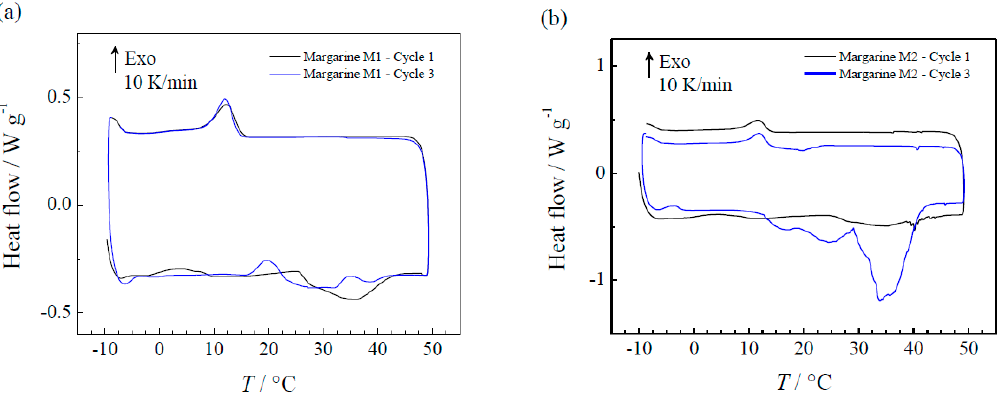
Figure 1. Di ff erential scanning calorimeter (DSC) thermograms of ( a ) margarine sample M1 (Parkay ® ) Figure 1. D ifferential scanning calorimeter (DSC) thermograms of ( a ) margarine sample M1 and ( b ) margarine sample M2 (Imperial ® ). The first and third cycles are (Parkay®) and ( b ) margarine sample M2 (Imperial®). The first and third cycles are shown.